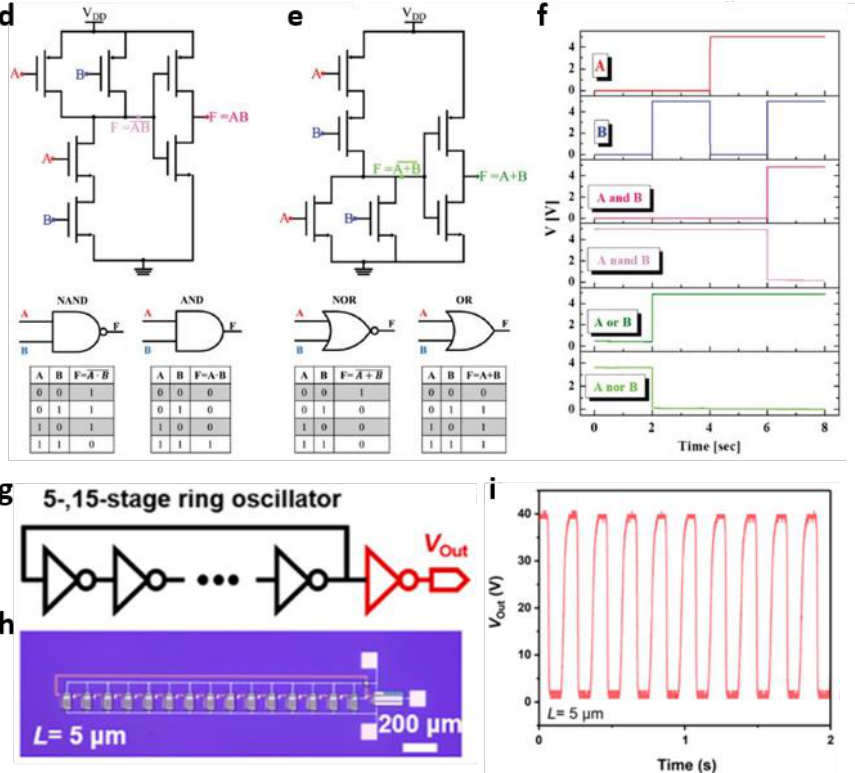
Figure 3. Organic-based digital thin-film circuits. ( a ) Schematic diagram of OTFT-based complementary inverter with a gate dielectric formed by selective printing and its corresponding ( b ) voltage transfer characteristics and ( c ) gain (adapted from [ 51 ] with permission from the American Chemical Society). ( d ) Circuit schematic, symbol, and truth table of ( d ) NAND, AND and ( e ) NOR, OR composed of N1400-based n -type OTFT and TIPS-Pentacene-based p -type OTFT. ( f ) Two different input voltages (A, B) and corresponding output voltages of AND, NAND, OR, and NOR circuits (adapted from [ 54 ] with permission from John Wiley and Sons). ( g ) Schematic symbol, ( h ) optical microscopy image, and ( i ) output characteristics of 15-stage organic ring oscillator (adapted from [ 55 ] with permission from the American Chemical Society).